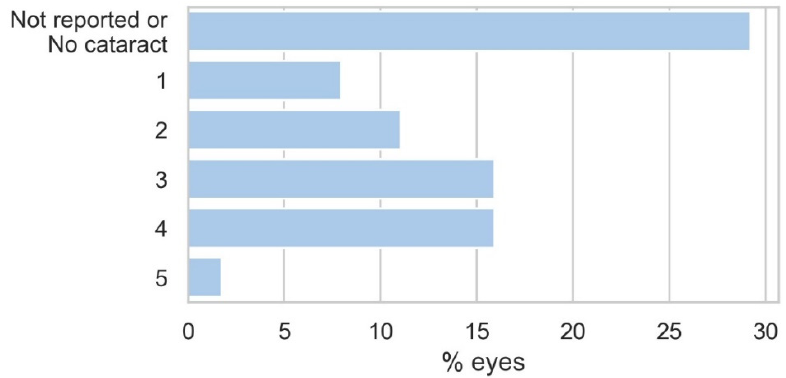
Figure 6. Lens opacities classification of cataract study patients.